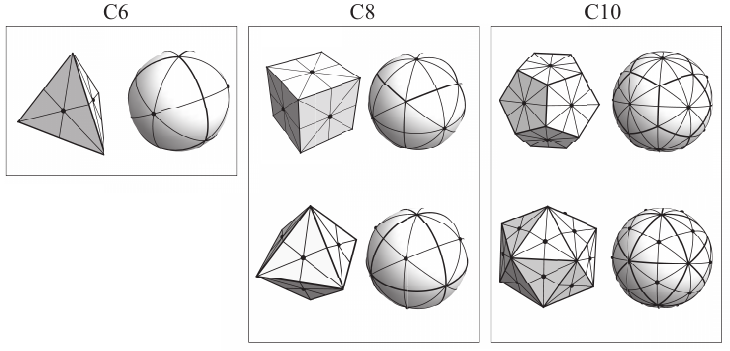
Fig. 5 Divisions of Platonic polyhedrons and their projections to spherical surfaces. Figure 6. Correspondences between Platonic and spherical polyhedra.